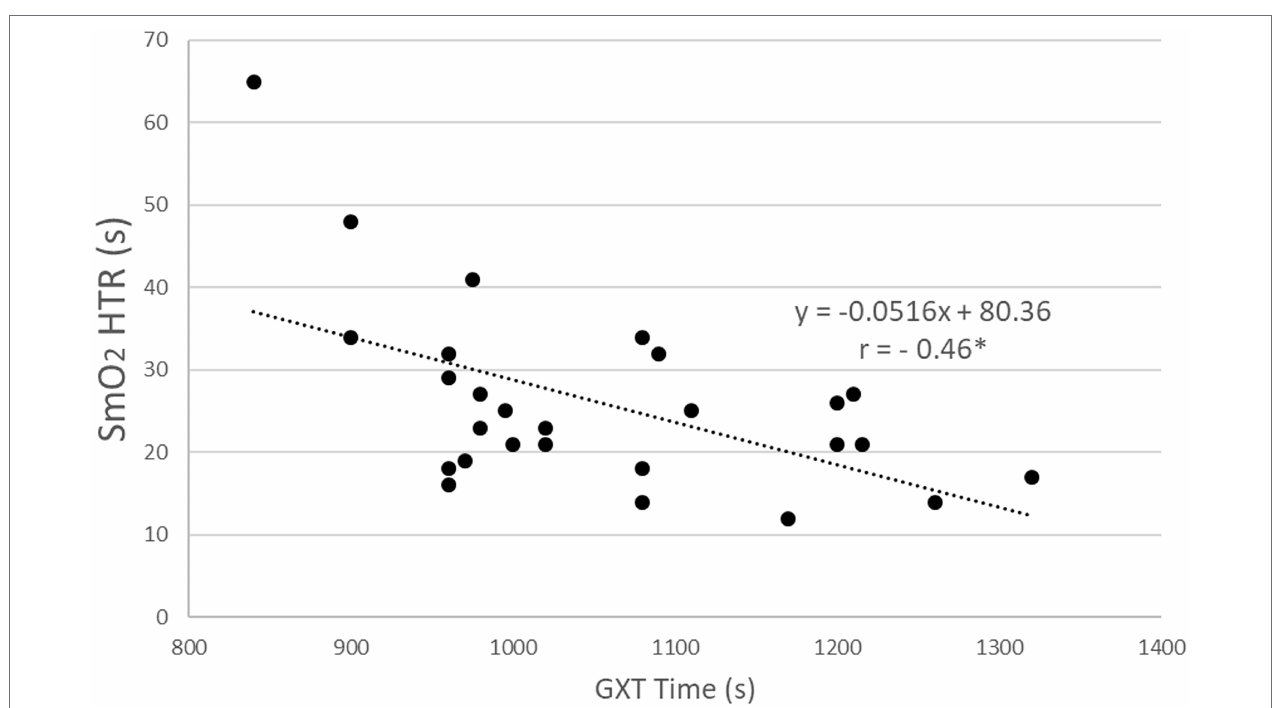
FIGURE 2 | Statistically significant Spearman’s rank correlation between half time for SmO 2 to reach the maximal value (SmO 2 HTR) and test time in the graded exercise test (GXT) in the combined group of female and male speed skaters ( n = 27). * p <